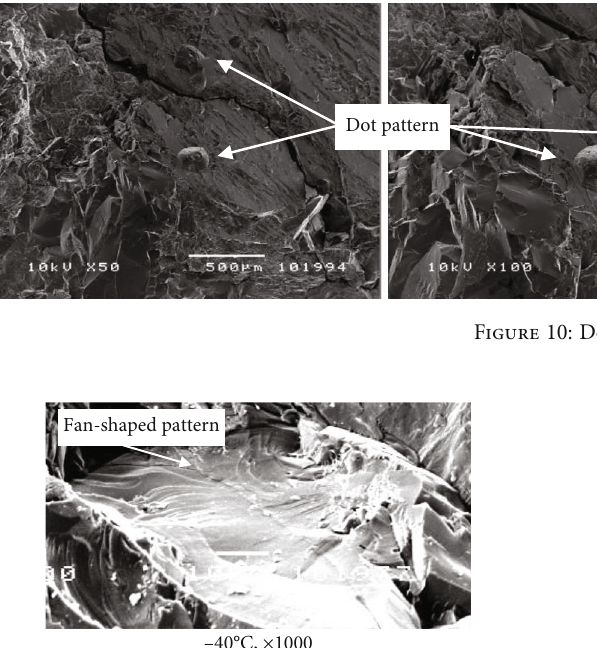
Figure 11: Fan-shaped pattern.